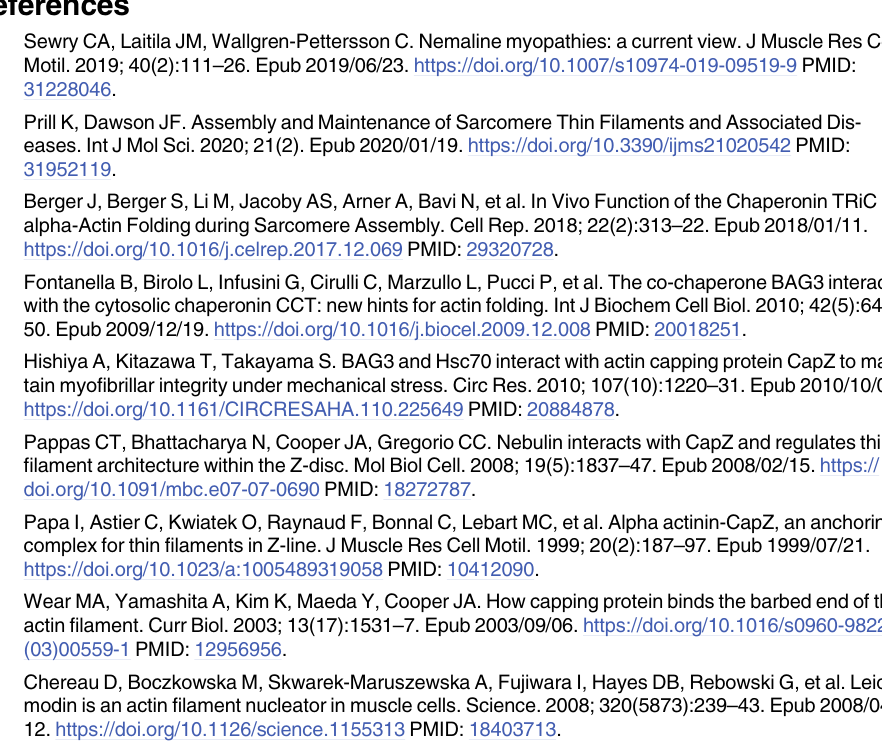
S1 Data. Raw data of values presented in graphs within